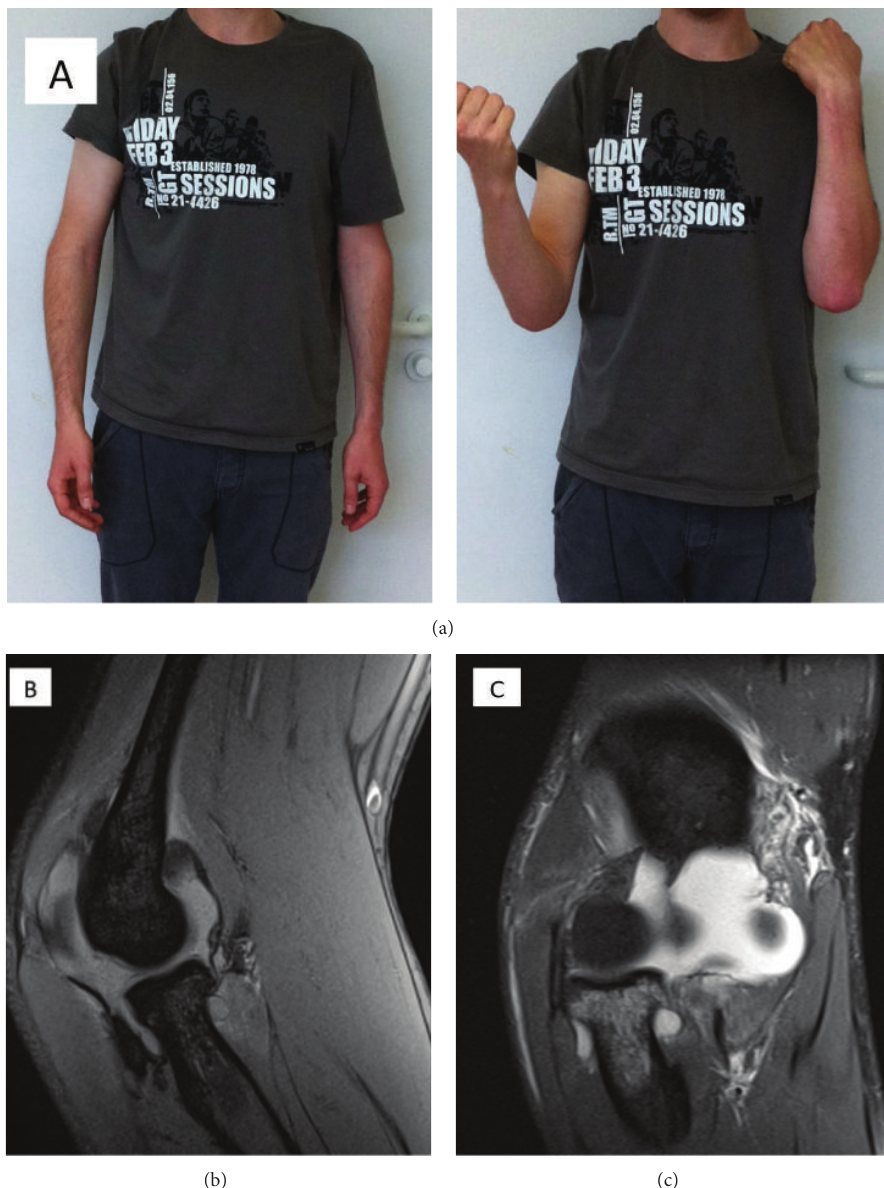
Figure 5: (a) Isolated rupture of the anterior medial ulnar collateral ligament (aMUCL) by valgus stress trauma. The patient was typically suffering from a limited range of motion in flexion. Full range of motion with a stable elbow was restored with conservative treatment 10 weeks after trauma. (b) MRI proofed isolated aMUCL rupture of the photographed patient. The sagittal plane illustrated an inflammatory reaction. (c) The frontal plane demonstrated the rupture of the MUCL complex from its proximal insertion on the medial epicondyle